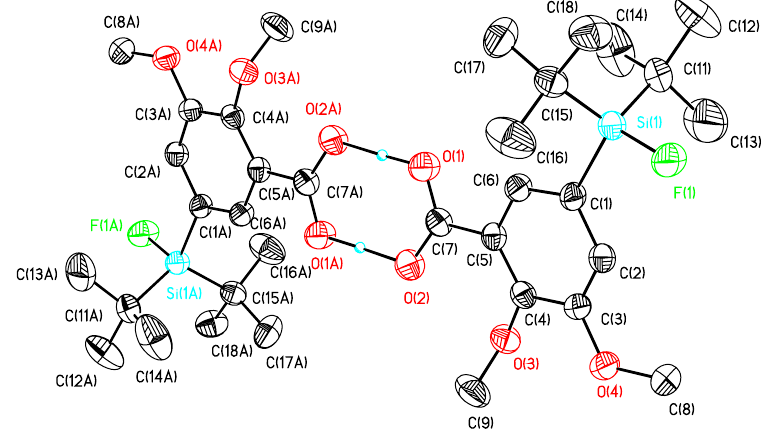
Figure 5. Molecular structure of 12b . Atomic displacement parameters are drawn at 30% probability level.